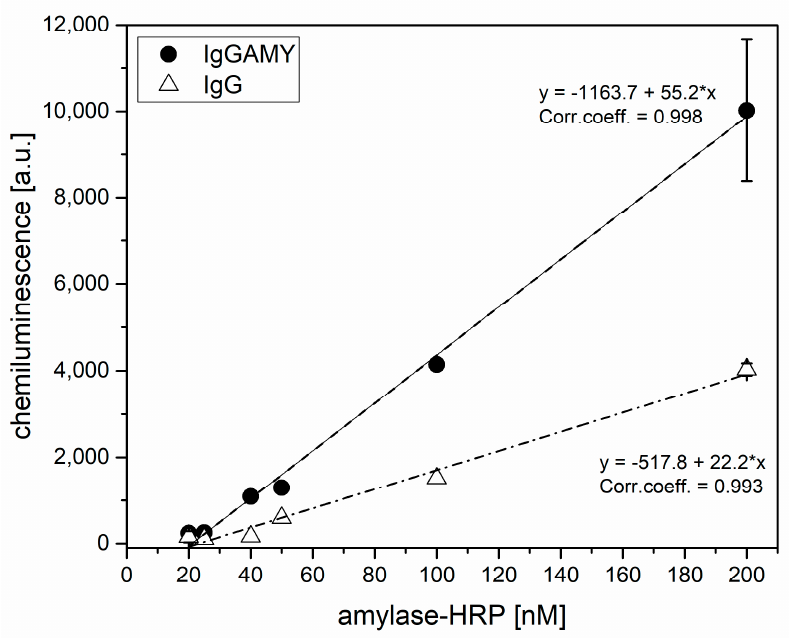
Figure 4. HRP-amylase chemiluminescence signal detected on flat gold surfaces prepared with specific antibody (IgG AMY) or aspecific one (IgG) in the linear range. Data are reported as the mean of two independent experiments and the error bars represent standard deviation.